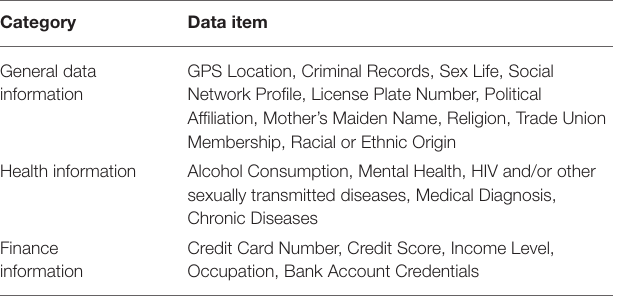
TABLE 3 | Reduced set of 20 data items used in the final stage of the study. Category